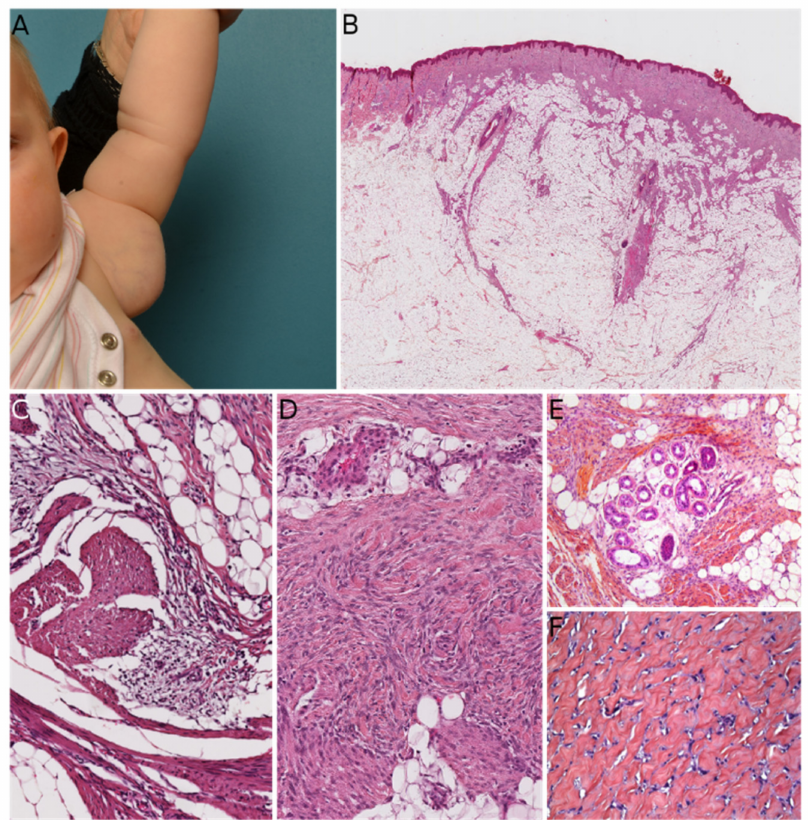
Figure 3. Fibrous hamartoma of infancy (FHI). ( A ) Typical clinical presentation as an axillary mass (courtesy of the Department of Maxillofacial Surgery, Necker-Enfants Malades hospital, Paris, France). ( B ) Low-power view of the lesion showing location in the subcutis and extension of the spindle-cell component into the dermis (HE × 50). ( C ) Presence of the three typical components (mature fibrous tissue, mature adipose tissue, immature mesenchymal tissue) (HE × 100). ( D ) In some cases, the immature mesenchymal tissue is not visible (HE × 100). ( E ) Peri-eccrine extension of the lesion (HES × 100). ( F ) Hyalinized zone reminiscent of giant cell fibroblastoma (HES ×